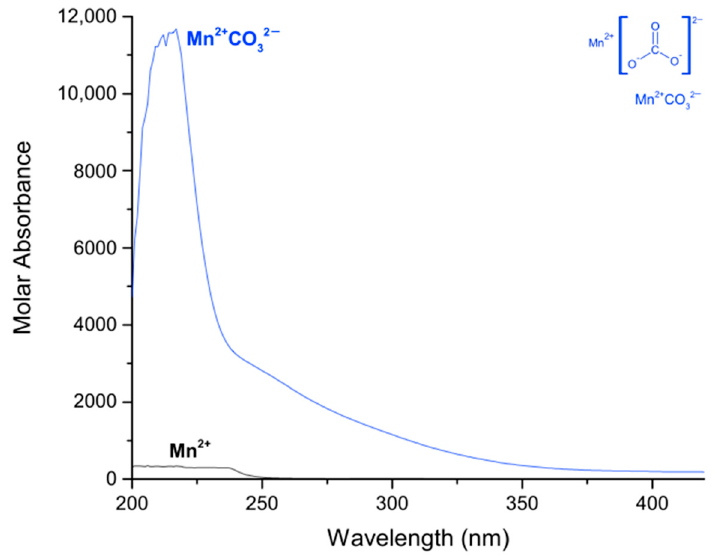
Figure 4. Calculated electronic spectrum of manganese(II)–carbonate in methanol: Mn 2+ and [Mn(CO 3 )] 2+.